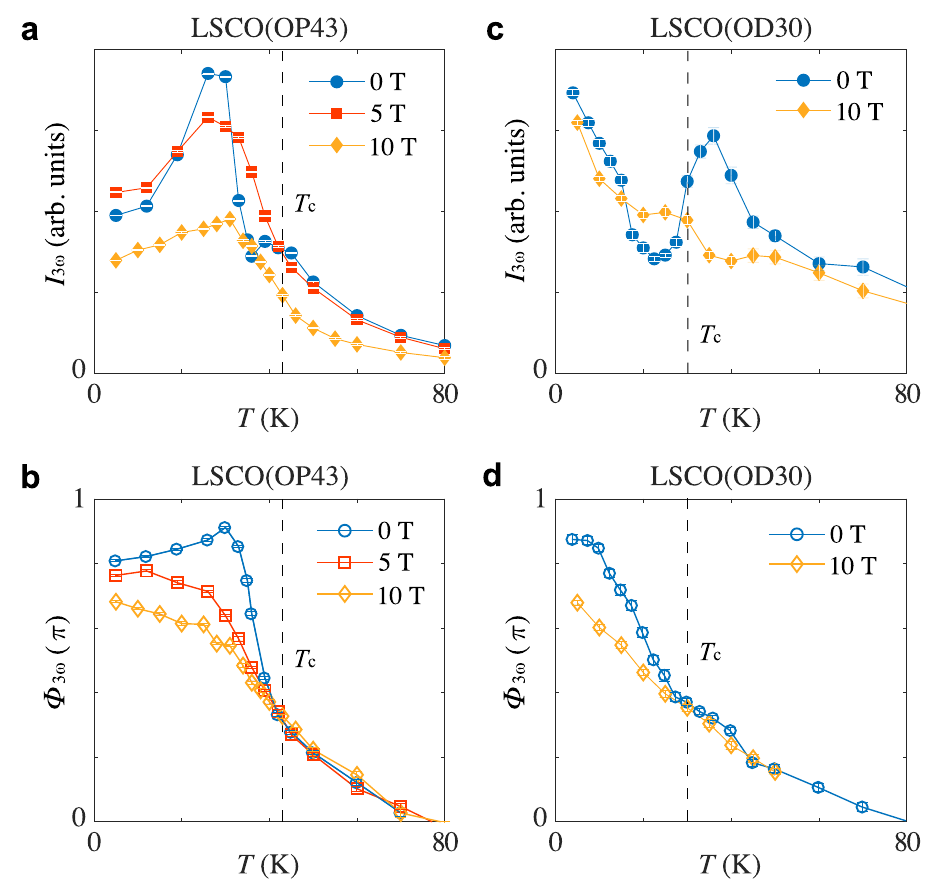
Fig. 4 | Magnetic fi eld dependence of Fano interference in La 2-x Sr x CuO 4 . a , c Temperaturedependenceof I 3 ω withamagnetic fi eldappliedalongthe c -axisof a x ~0.16(OP43), c x ~0.30(OD30). b , d Correspondingtemperaturedependenceof